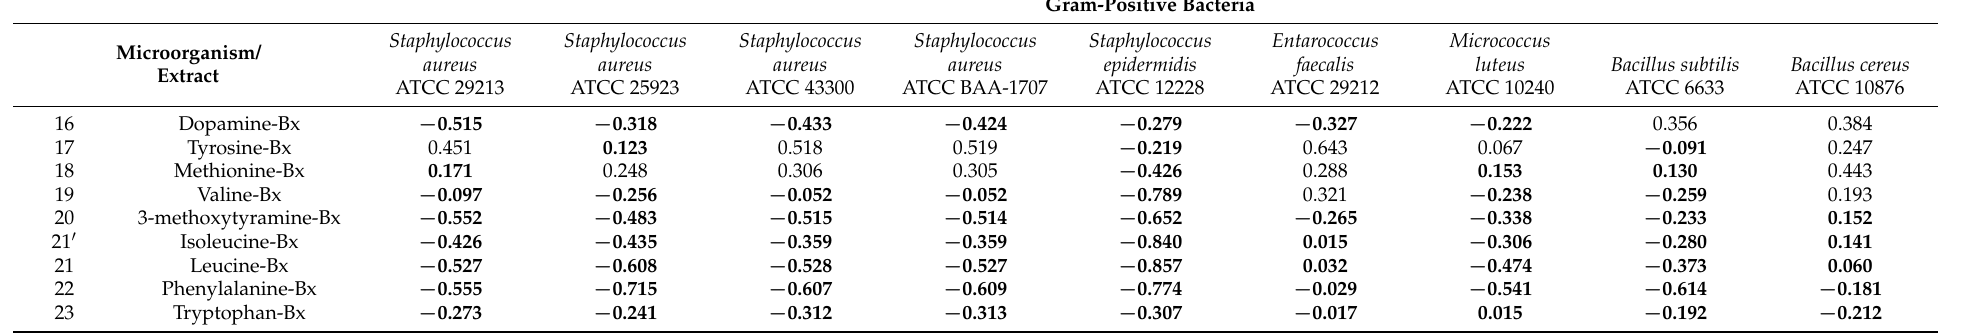
Table 5. Antimicrobial activity of extracts obtained from red and yellow B. vulgaris cultivars assessed as MIC (minimum inhibitory concentration) and